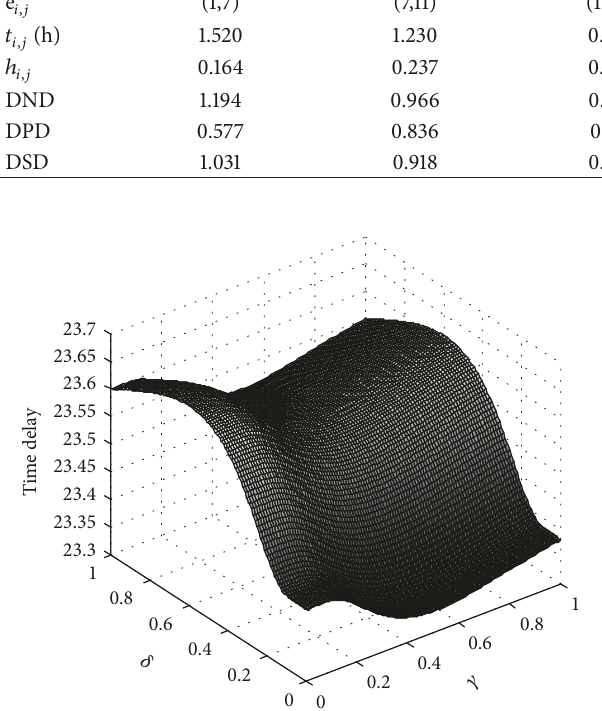
Figure 17: The influence of time delay caused by 𝛾 and 𝛿 .